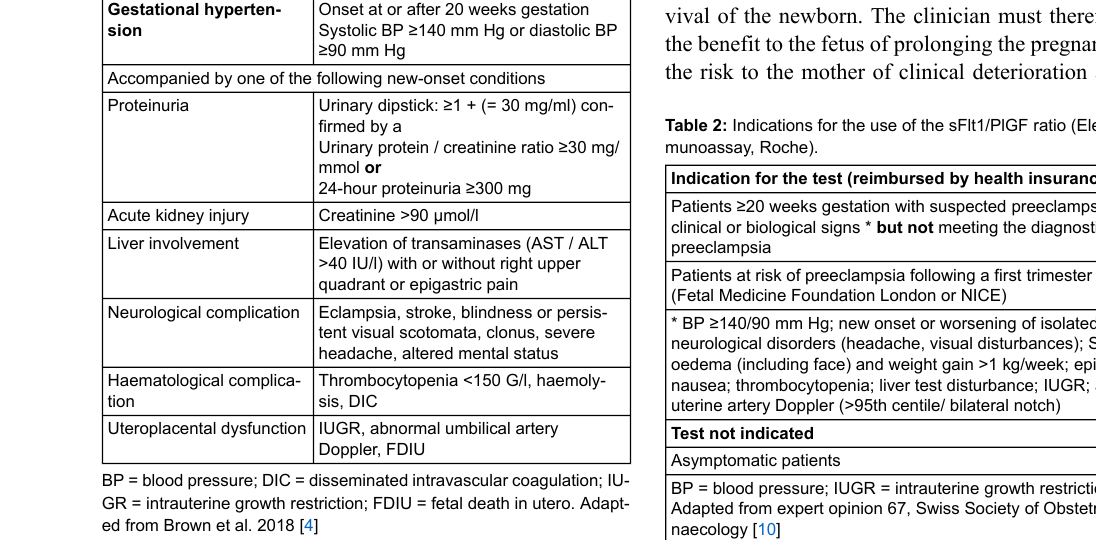
Table 1: ISSHP (International Society for the Study of Hypertension in Pregnancy) criteria for the diagnosis of preeclampsia. Clinical/ biological signs